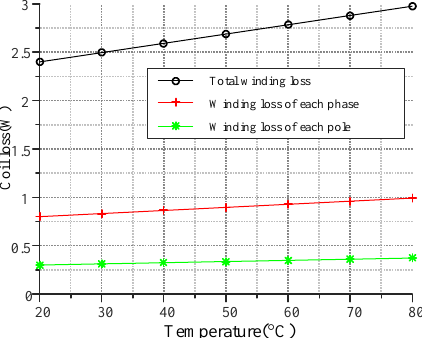
Figure 11. Winding loss of the BLDCM affected by temperature.